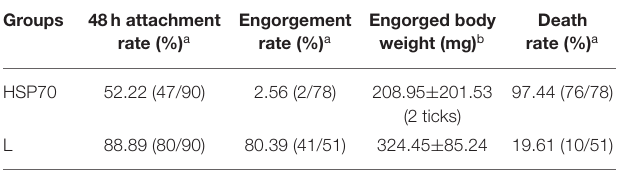
TABLE 2 | Effect of HSP70 gene knockdown on tick blood feeding and death rate. Groups 48h attachment rate (%) a